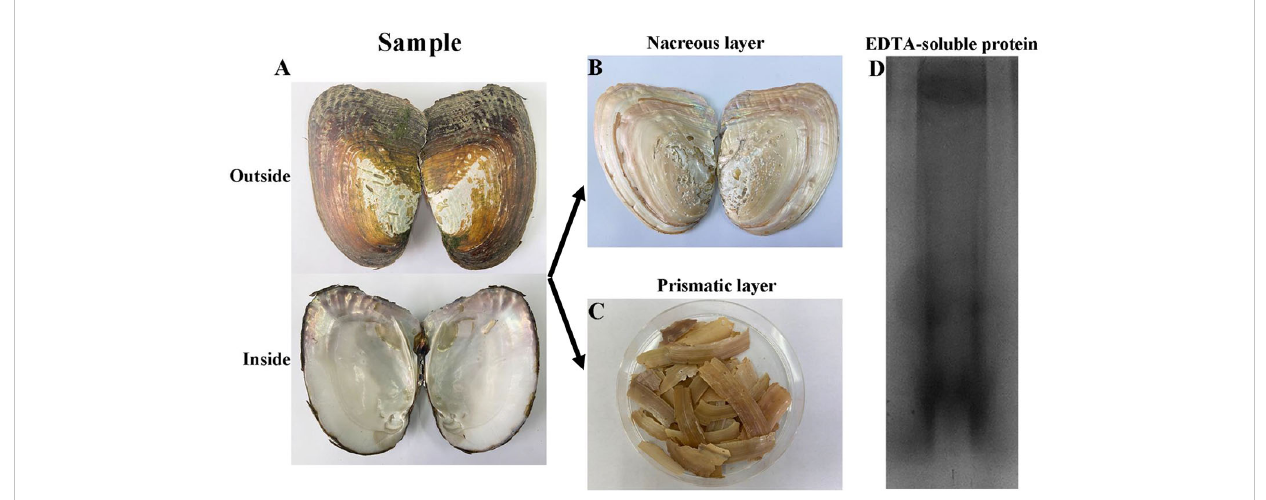
FIGURE 1 Extraction of EDTA-soluble matrix proteins of prismatic layer. (A) The inner and outer surfaces of H. cumingii ; (B) The nacreous layer of shell; (C) , The prismatic layer of shell; (D) EDTA-soluble extracts from prismatic layer of H. cumingii were fractionated by